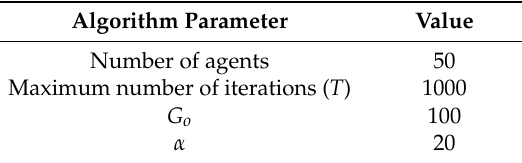
Table 2. GSA applied